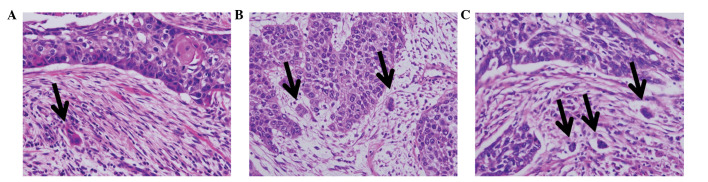
Microscopic findings of lung squamous cell carcinoma (hematoxylin and eosin staining). Tumor budding is defined as single cancer cells and/or clusters composed of up to four cancer cells. (A) One, (B) two and (C) three budding foci.